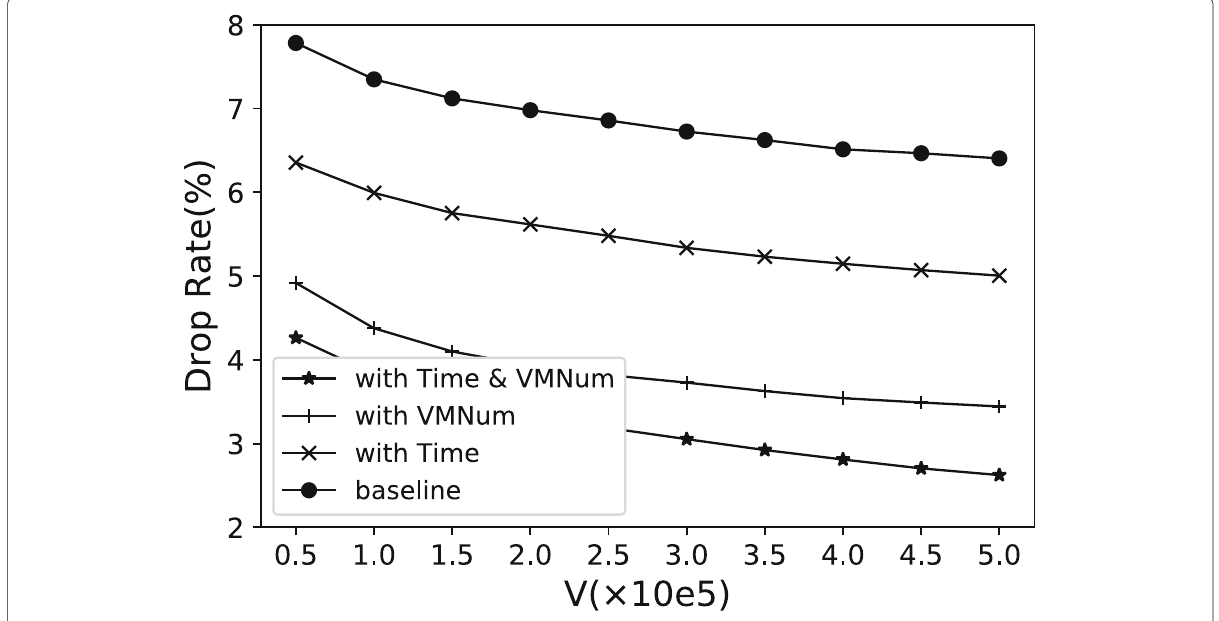
Fig. 7 Comparison of job drop rate with different values of